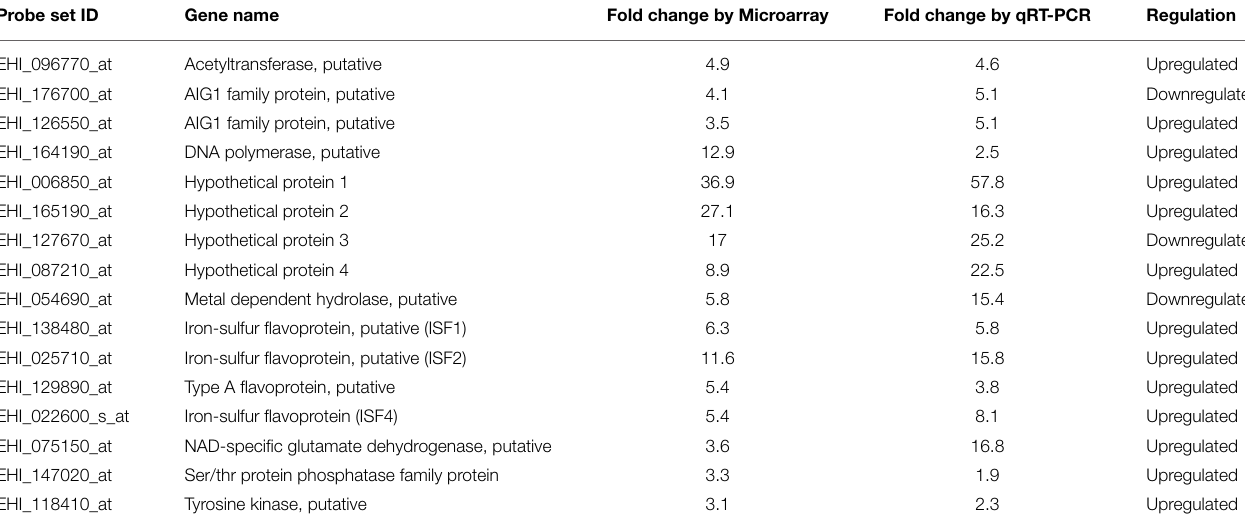
TABLE 4 | qRT-PCR validation of selected genes from our microarray data. Probe set